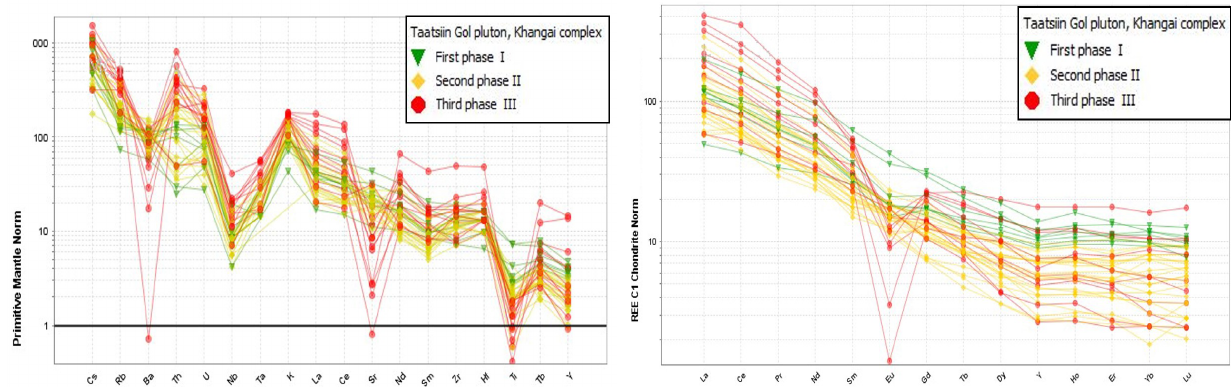
Fig 16. Chondrite normalized REE element spider diagram of Taatsiin Gol pluton, Khangai Complex (Sun and McDonough,